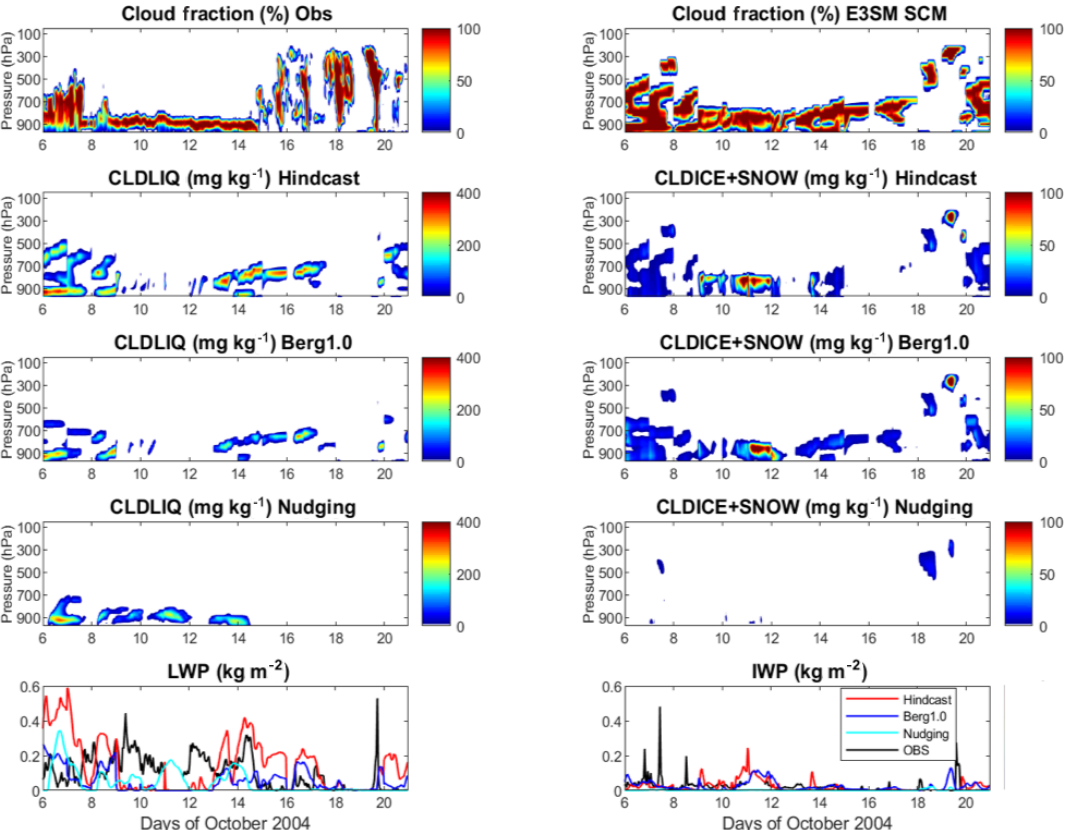
Figure 4. Top panel displays the evolution of the vertical cloud structure for cloud fraction (observations on the left and E3SM SCM on the right) for the MPACE case from October 2004. The second through fourth panels on the left column represent the cloud liquid mixing ratio, while the second through fourth panels of the right column represent cloud ice mixing ratio from E3SM SCM simulations). The second row represents simulations using the hindcast method, the third row represents simulations with the Bergeron–Findeisen process set to the default tuning value, and row four represent the simulations where temperature and moisture are nudged to observations. The bottom row displays the evolution of the integrated liquid (left) and ice (right) path for the various configurations